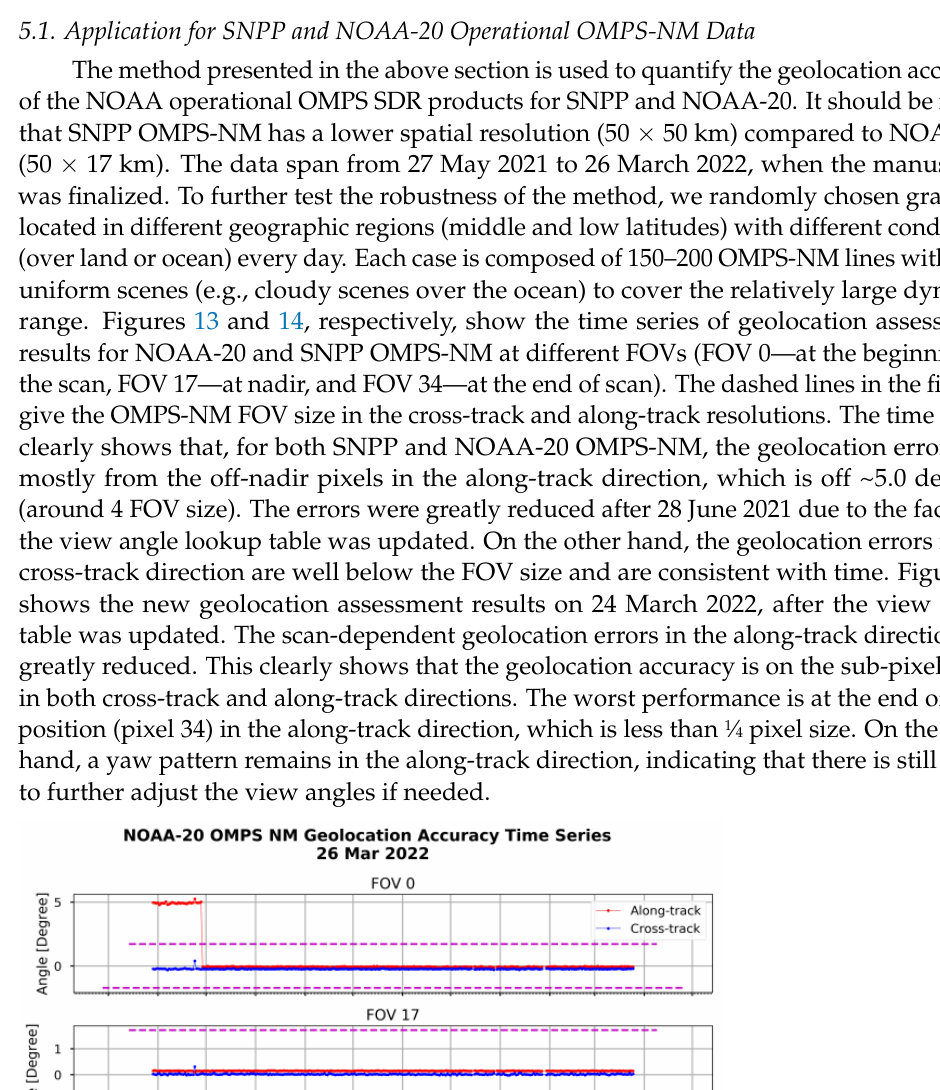
Figure 14. Same as Figure 13 but for SNPP OMPS-NM. Figure 15. Same as Figure 11 but on 24 March 2022 after the view angle table was updated. 5.2. Potential Application for Future High-Resolution OMPS-NM Data As discussed in the introduction section, the spatial resolution of the future OMPS- NM on JPSS-2 will be further improved in both cross-track (with less CCD pixels aggerated) and along-track (with less integrating time) directions. Therefore, it is important to test whether the proposed method can work for future high-resolution